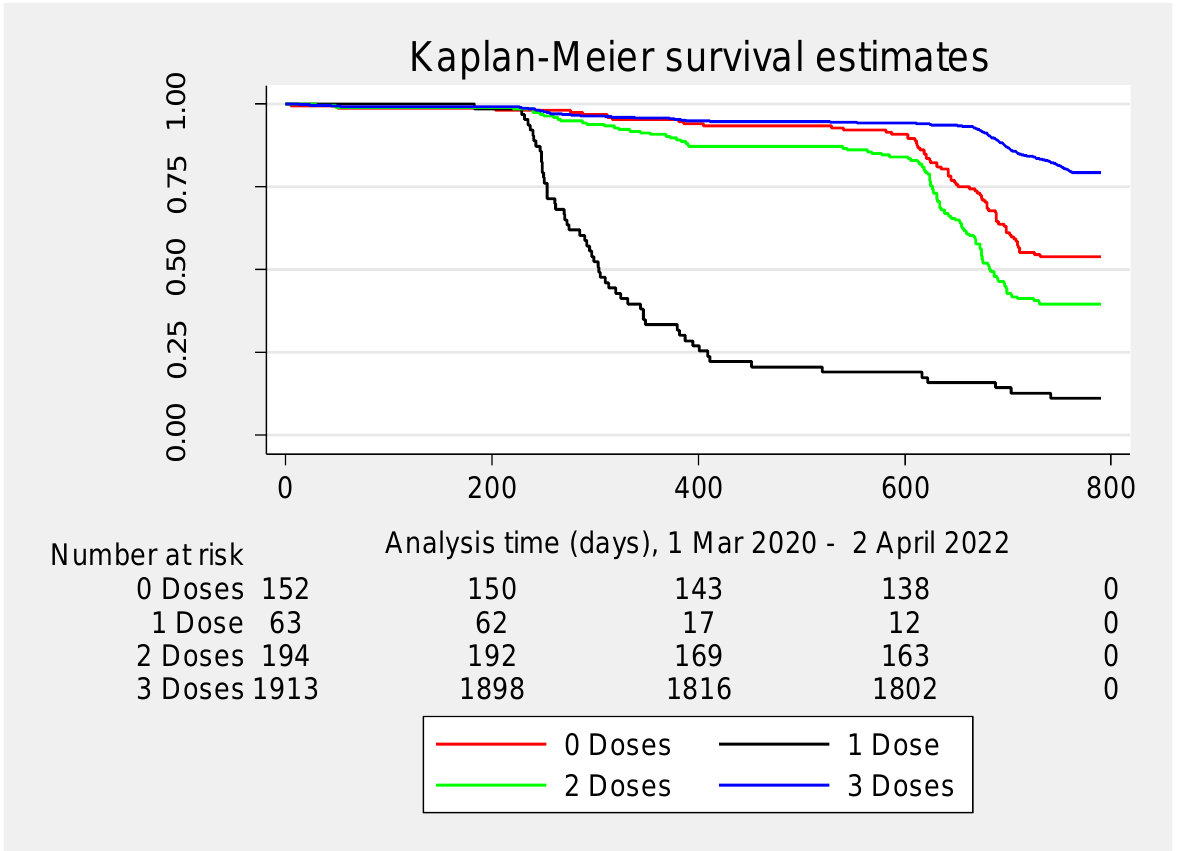
Figure 4. Kaplan–Meier survival curve for the risk of primary SARS-CoV-2 infections by the number of doses of COVID-19 vaccines, regardless of whether they preceded primary SARS-CoV-2 infections. Table 6. Multiple Cox proportional regression model contrasting the risk of SARS-CoV-2 infection with heterologous (two doses of Vaxzevria, followed by one dose of an m-RNA vaccine) versus homologous immunization (three doses of COVID-19 m-RNA vaccines) during the Omicron trans- mission period (1 December 2021–2 April 2022). Hazard ratio (HR) with a 95% confidence interval (95% CI). All Cox regression models fitted onto 1752 complete case analysis observations. Dpt. = University As can be seen, the risk of primary SARS-CoV-2 infection in those immunized with a ho- mologous booster was significantly higher in the crude analysis (HR = 1.76; 95% CI: 1.37; 2.27) and was confirmed in the model adjusted for sex (aHR = 1.76; 95% CI: 1.36; 2.27), as